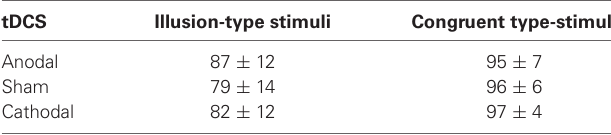
Values are described by Mean ( + / − SD) of